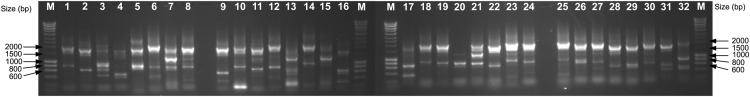
PCR3 amplifications.Example gel image for 32 of the PCR3 amplifications. Columns H contain 5 μl Hyperladder 1. Expected product sizes (bp) are as follows, Rows 1–8: 2110, 1913, 2358, 1744, 1956, 2312, 2064, 2090, blank, Rows 9–16: 2080, 2159, 2041, 2332, 1833, 2235, 2163, 1811. Rows 17–24: 1862, 2152, 2084, 2079, 2024, 1918, 2121, 2062, blank. Rows 25–32: 2140, 2015, 2024, 1831, 1784, 2242, 1824, 2030. Extra bands are generally those corresponding to the sizes of PCR1 and PCR2 products. Full details given in S12 and S13 Figs, S5 and S8 Tables.